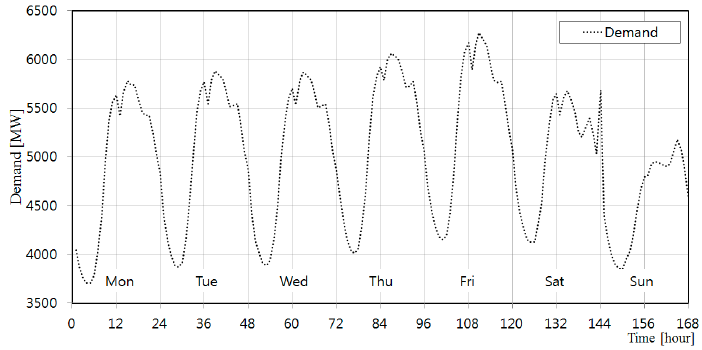
Figure 1. Demand for a week.